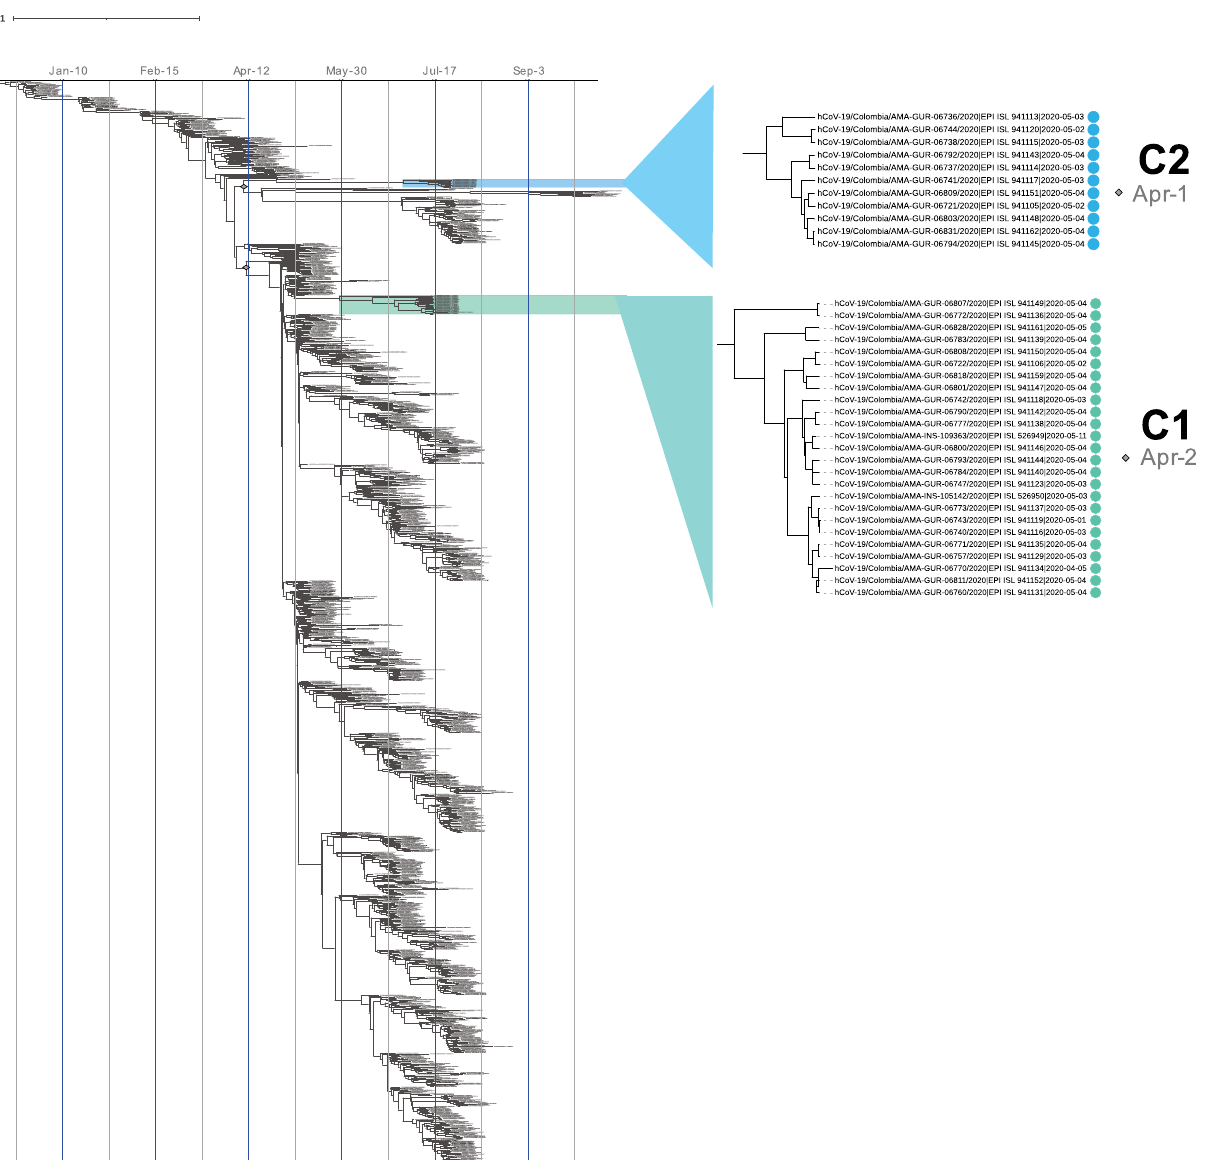
Fig 3. Bayesian phylogenetic tree built from 1,436 genomes including the 59 Colombian Amazonas sequences of this study and a worldwide representation. Both clusters identified in this study are highlighted in specific colors. The color cyan represent the cluster 1 and the GISAID clade G, and the blue color represent the cluster 2 and the GISAID clade GH. A zoom showing the IDs of the genomes belonging to each cluster is showed on the right panel. Additionally, the diamond figures represent the putative introduction dates, April 1 and April 2, 2020, respectively.